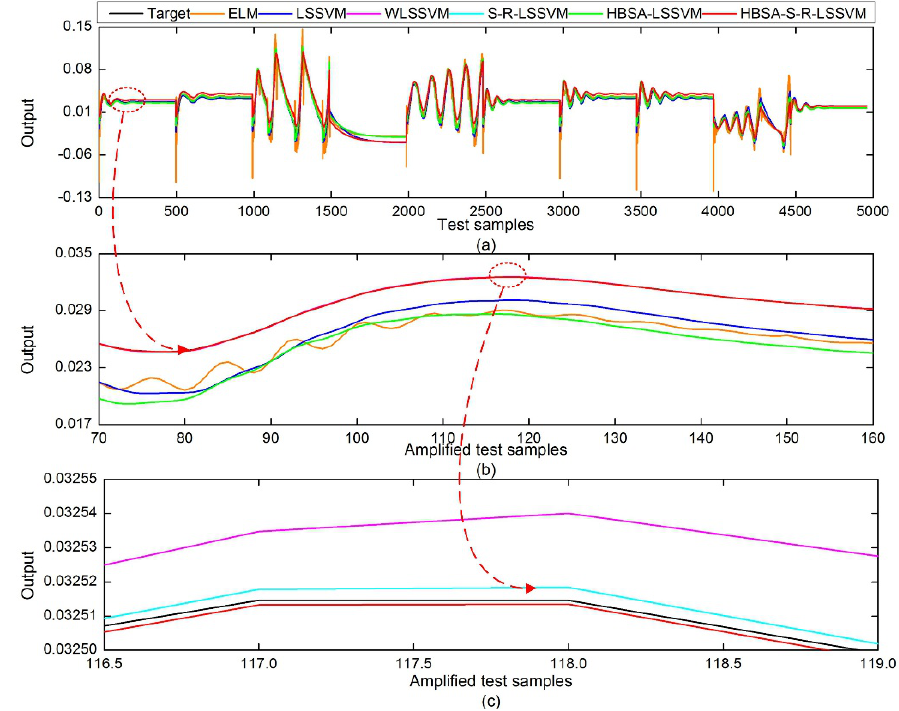
Figure 10. Comparison of the predicted output of each identification model and target output under Scheme B.